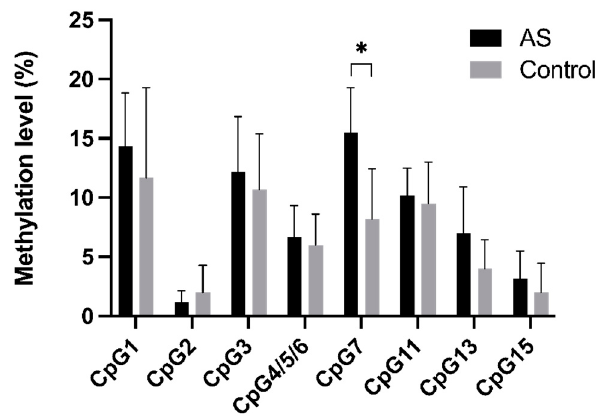
Figure 14. Comparison of methylation levels of 10 CpG sites (CpG1–7, 11, 13, and 15) at LMOD1 promoter in PBMCs from arteriosclerotic patients to the matched control subjects using the MassARRAY platform. * p < 0.05.